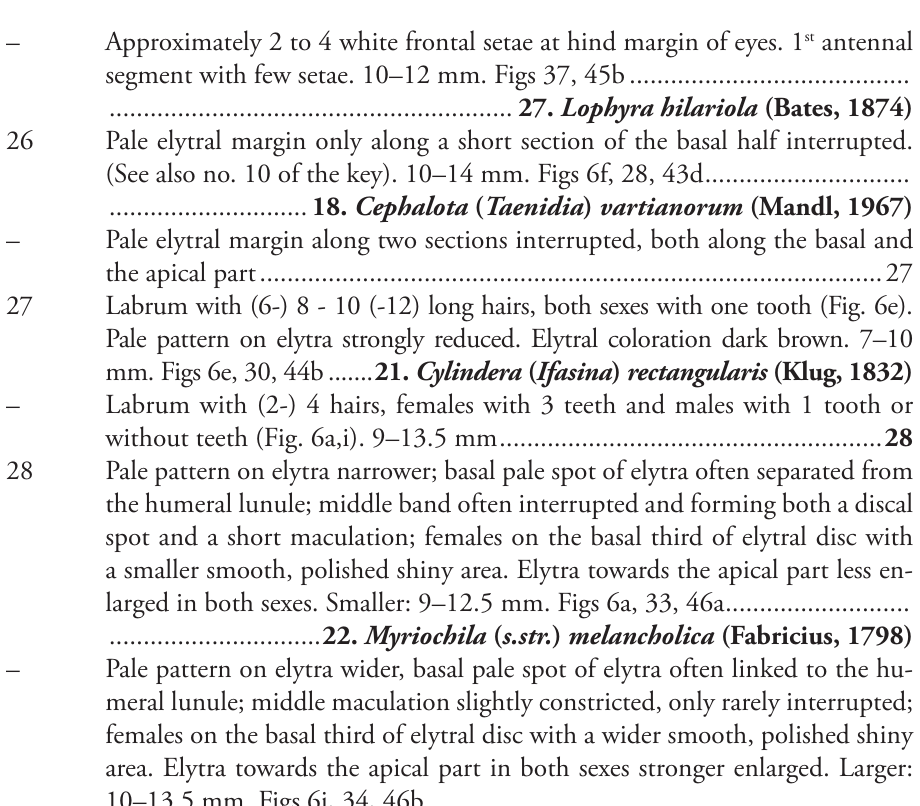
TIGER BEETLES ID: the application for smartphones and tablets The above presented key for the tiger beetles of the southern Levant and adjacent territories is also available as a stand-alone application (app) for portable Android devices (Android-version 5.0 and later releases; Application Programming Interface (API) of 21 or higher is recommended), and can be downloaded from